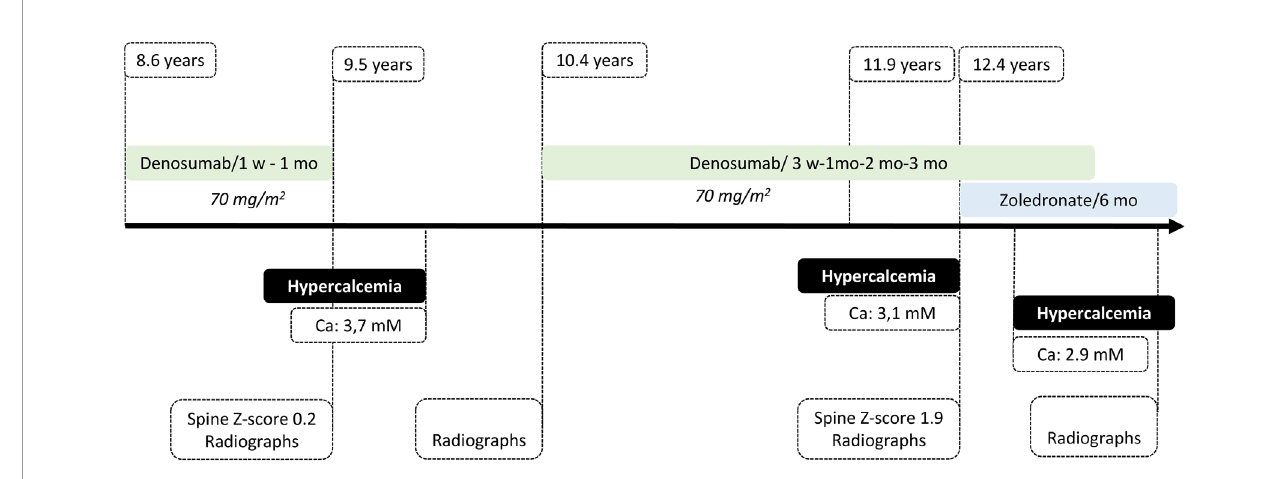
FIGURE 6 | Chart of the patient